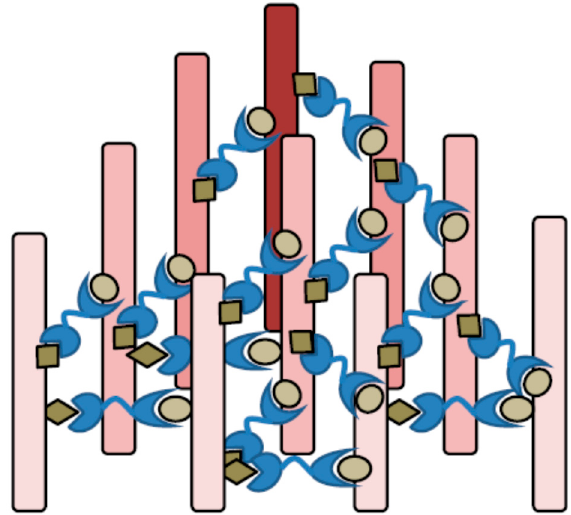
Figure 4. Lattice formation by galectin-9 and multivalent glycoconjugates. The galectin-9-glycan lattice provides higher diversity based on the combination of 10 monosaccharide species on glycoconjugates, different sugar-affinity of galectin-9’s two distinct carbohydrate recognition domains (CRDs) and the rotational freedom of the CRDs that is allowed by flexible linker peptides. The galectin-glycan lattices could perform three major roles in cell biology, including organizing cell membrane domains, determining thresholds of cell signaling and restricting the receptor residency time on the cell surface.